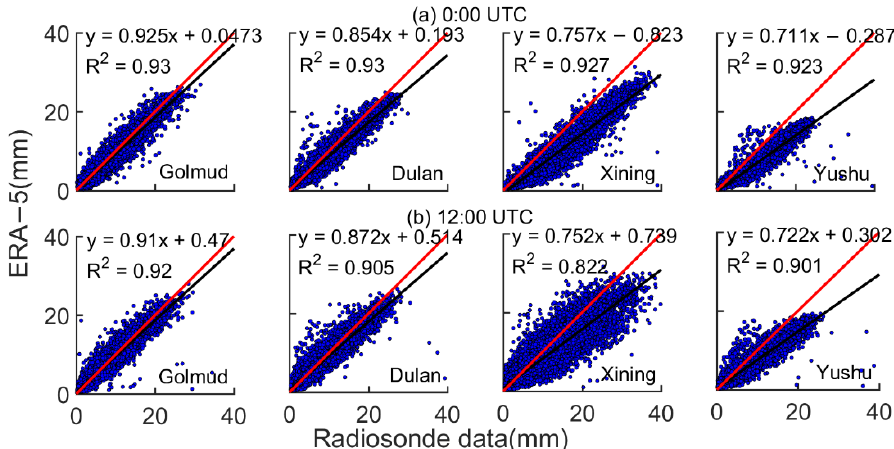
Figure 4. Scattered relationship diagram of PWV from radiosonde data and ERA-5 data (black solid line: scatter linear fitting; red solid line: y = x). ( a ) At 0:00 UTC, PWV scattered points were distributed in Dulan, Xining, Golmud, and Yushu stations. ( b ) At 12:00 UTC, PWV scattered points were distributed in Dulan, Xining, Golmud, and Yushu stations.